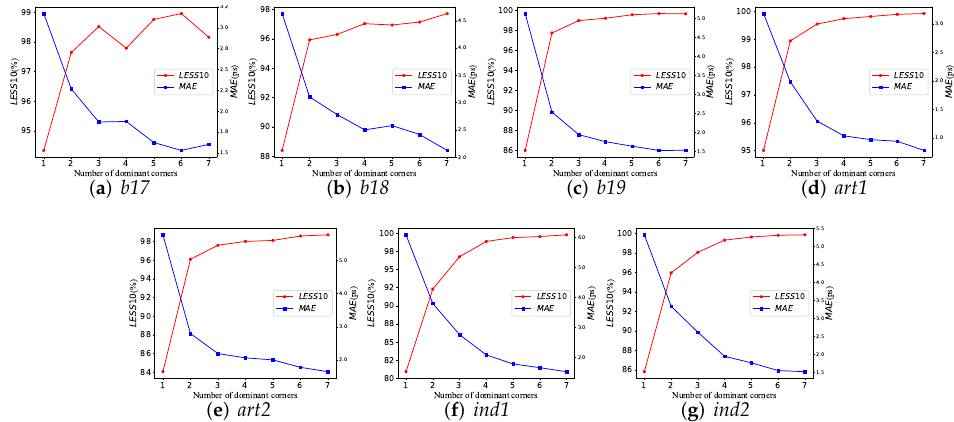
Figure 8. Performance evaluation of small-scale training data. Subfigures ( a – g ) show the evaluation of LESS 10 and MAE on all designs when the number of dominant corners varies from 1 to 7.